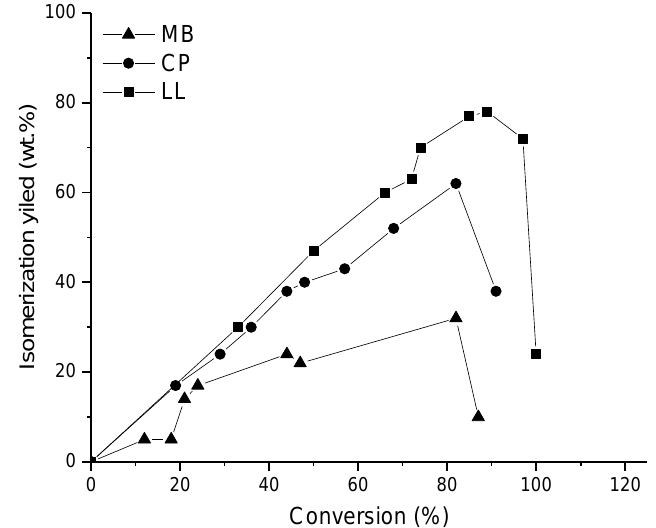
Figure 12. The yield of isomerization products as a function of conversion in hexadecane hydroisomerization over Pt-Beta, low loading Al 2 O 3 -H-Beta (LL) and high loading Al 2 O 3 -H-Beta [38]. Reproduced with permission from Batalha et al., Microporous Mesoporous Mater. ; published by Elsevier, 2013 .